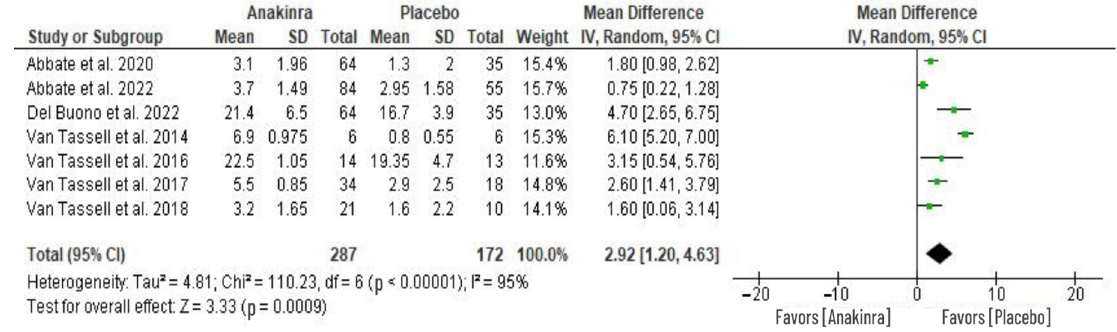
Figure 5. Anakinra effect on CRP levels [19,26–32].